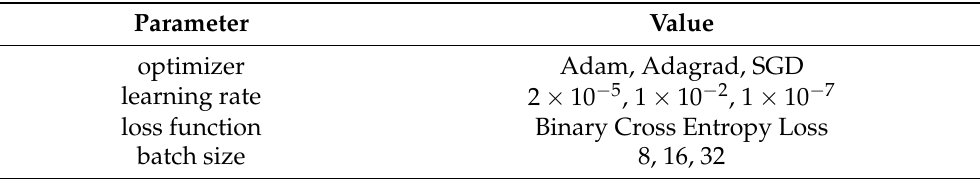
Table 5. Parameters to configure the neural network of Figure 5: optimizer, learning rate, and loss function batch